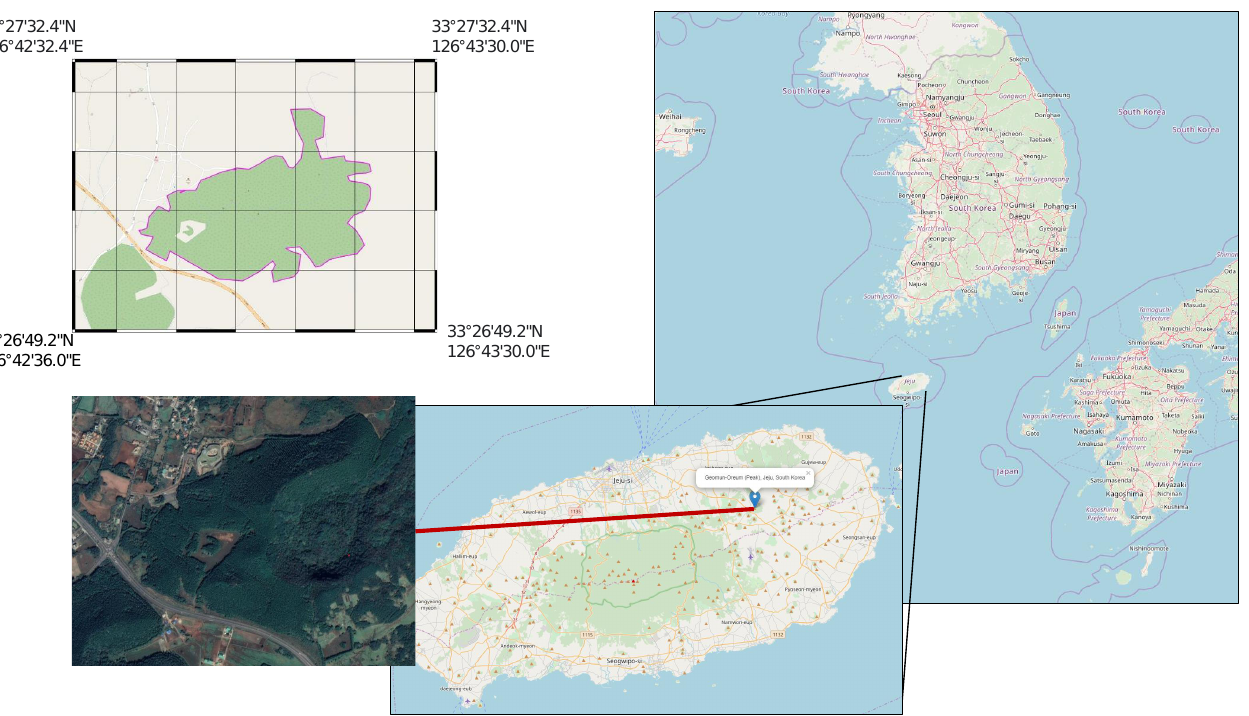
Figure 1. The study area, Geomunoreum, is located on Jeju Island in South Korea. The width and height of the study area are 1450 m and 1342 m,